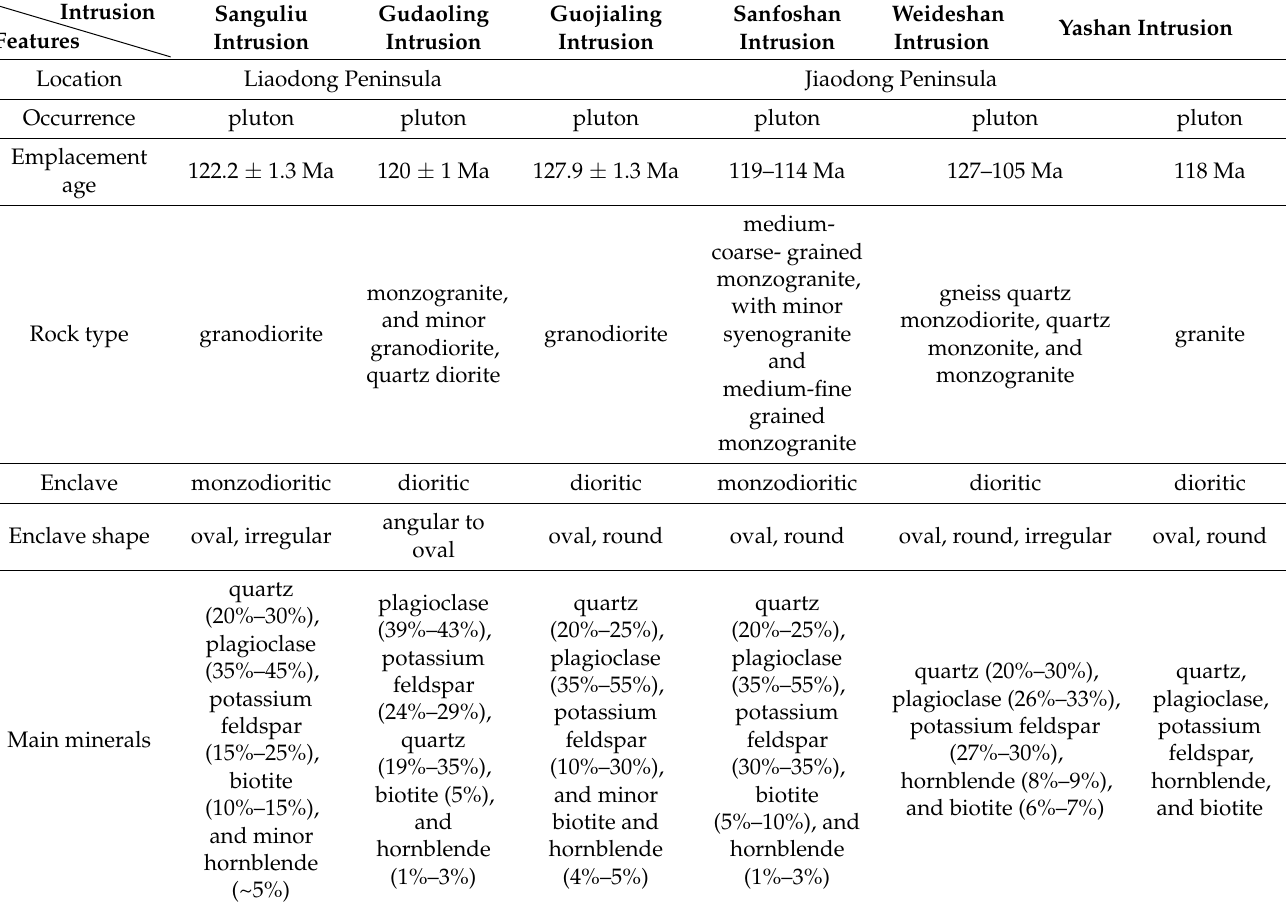
Table 8. Characteristics of the Early Cretaceous granitoids with MMEs in the Jiaodong and Liaodong